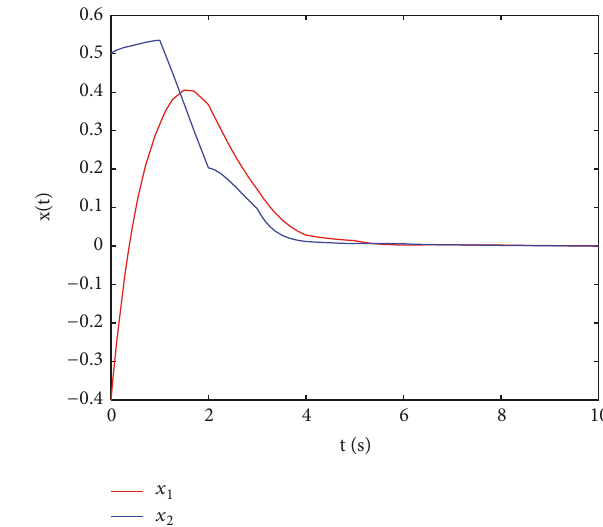
Figure1:Thestatetrajectoriesofsystem(1)with 𝜏(𝑡) = 0.2+0.1 sin 𝑡 .